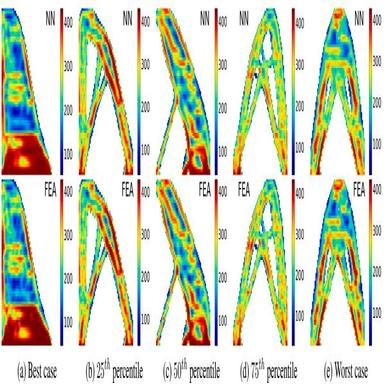
Stress predictions by ResUNet-based DeepONet compared to FEA for samples in (Rel. 2 Error).